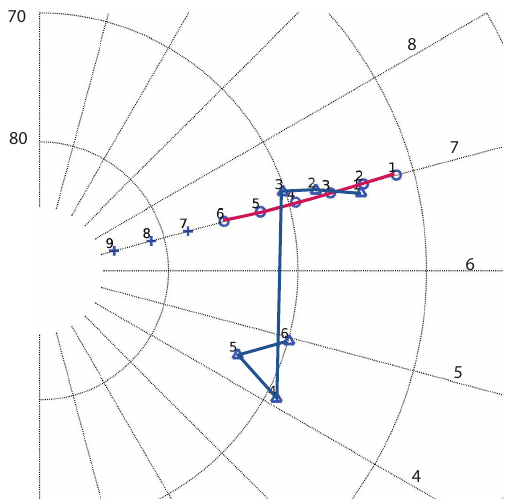
Figure 9. Tracing field lines from south (red), 62 to 75 ◦ at 7MLT, to north (blue) using the LFM model. The field lines from 70 to 75 ◦ latitude in the south map to an azimuthally extended region in the